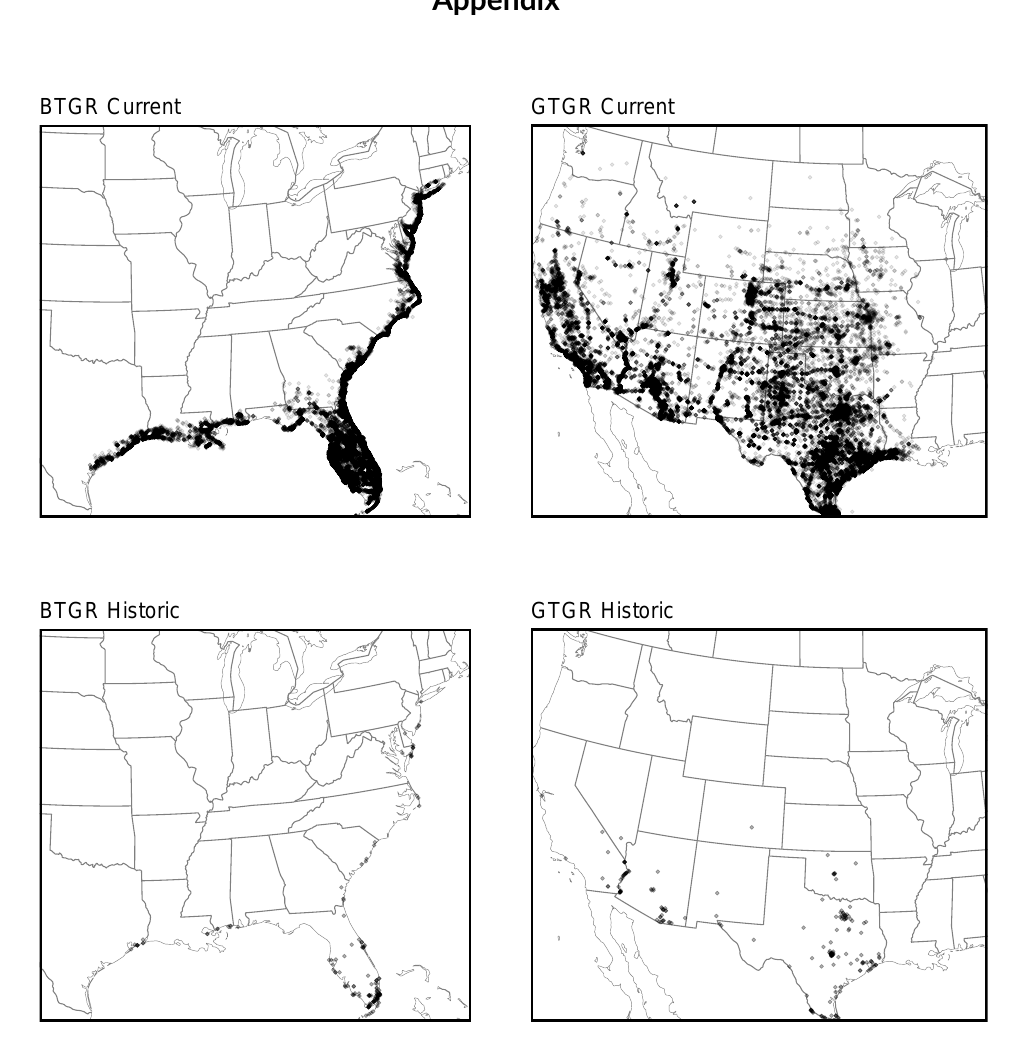
Supplementary Figure 1 – Map of observation locations for boat-tailed grackles (BTGR) or great- tailed grackles (GTGR) from historic (1970-1979) and current (2010-2019) eBird records. These locations are filtered for record